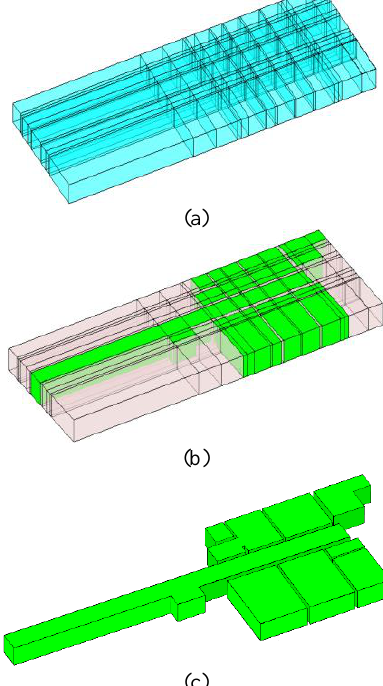
Fig. 7. Results for the TUB1 dataset: (a) 3D cell decomposition, (b) the classification of cells into navigable spaces (green) and non-navigable spaces (light pink), (c) the final model.